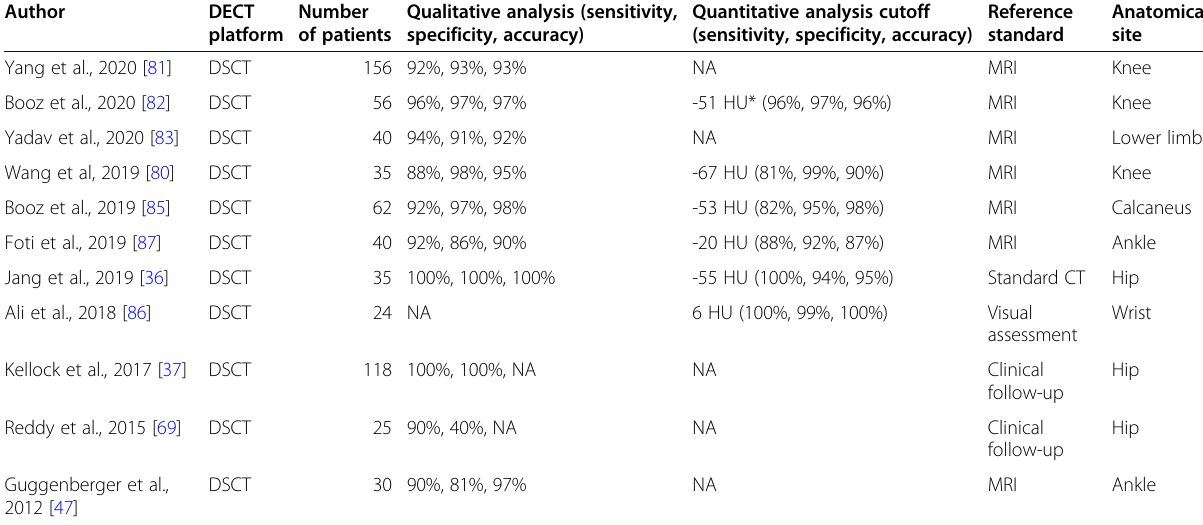
Table 4 Virtual non-calcium computed tomography ability to depict traumatic bone marrow edema on dual-energy scans of appendicular